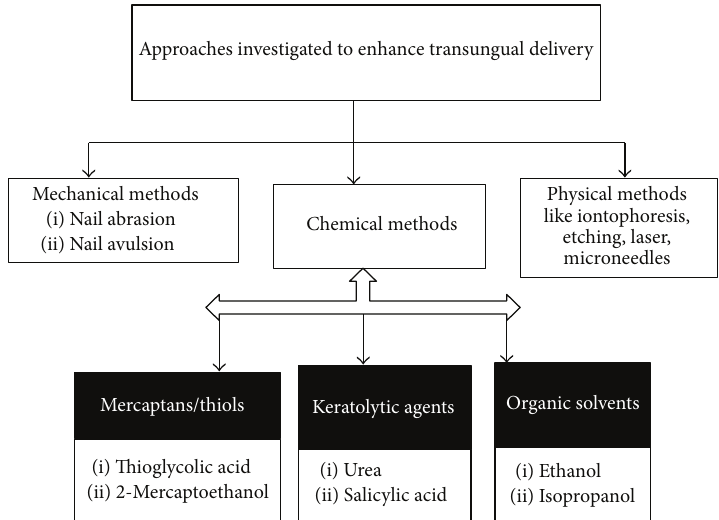
Figure 1: Various approaches for effective transungual drug